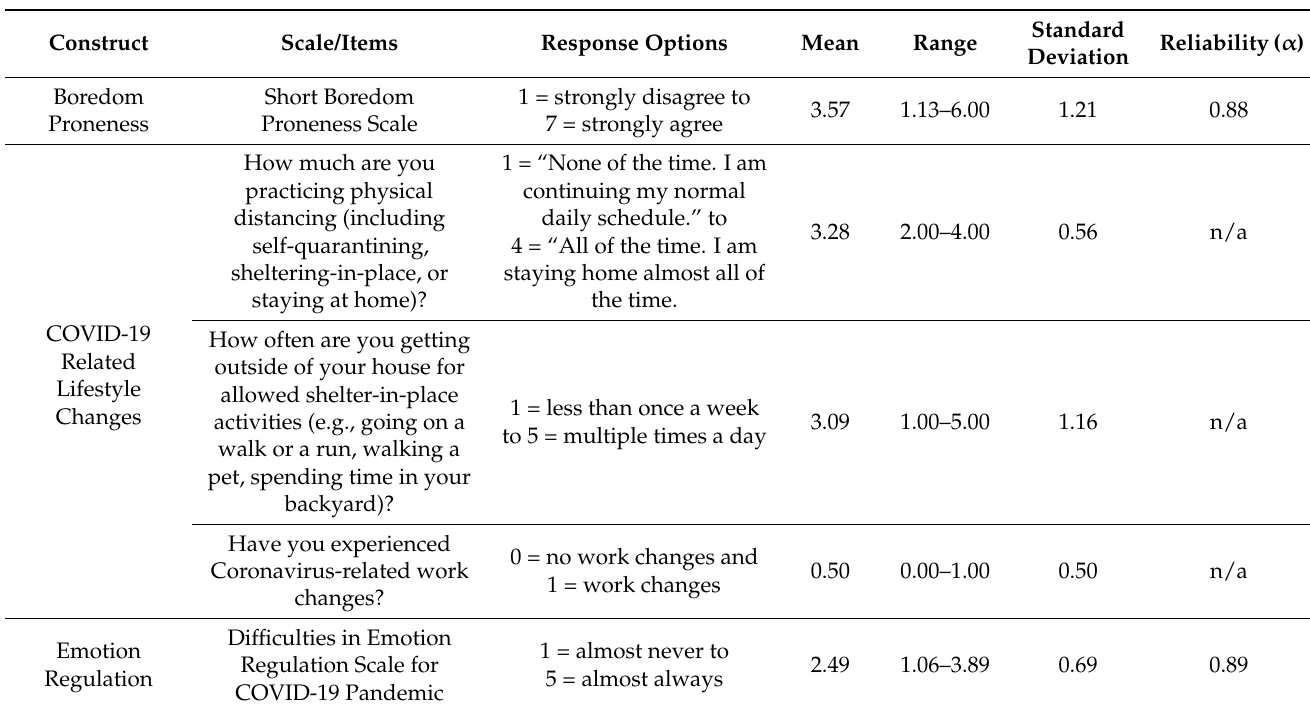
Table 1. Descriptive statistics for study